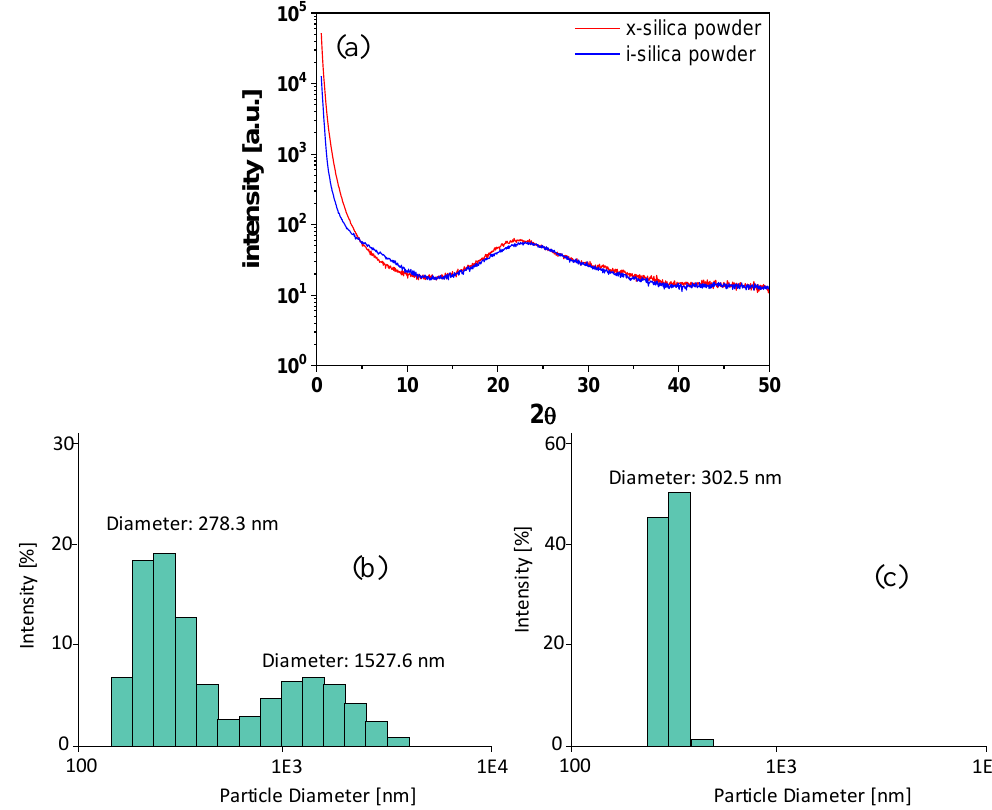
Figure 3. ( a ) X-ray diffraction patterns of in-situ silica and precipitated silica powders. Particle size histograms of ( b ) precipitated silica (Ultrasil-VN3) and ( c ) in-situ silica, from dynamic light scattering measurements.